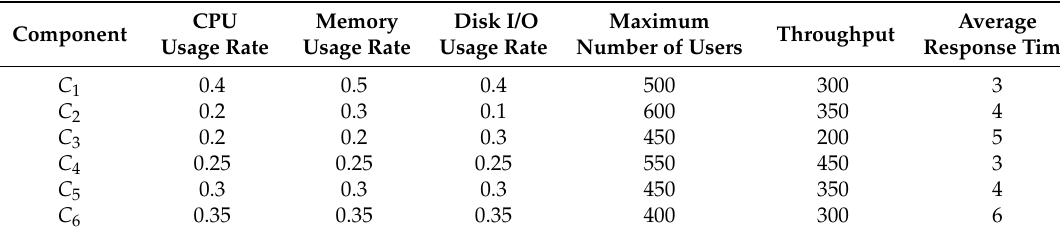
Table 8. The values of the metric elements of the component.